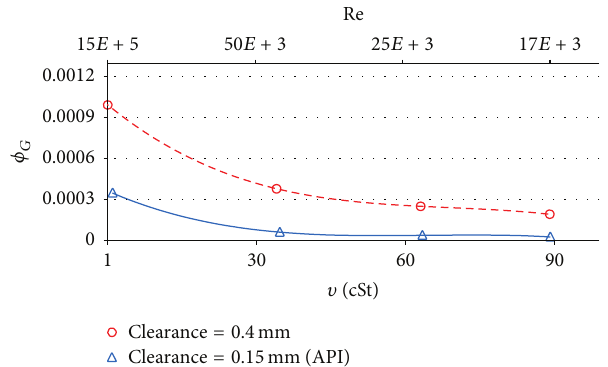
Figure11:Leakageratethroughfrontwearringsversusviscosityand Reynolds number.